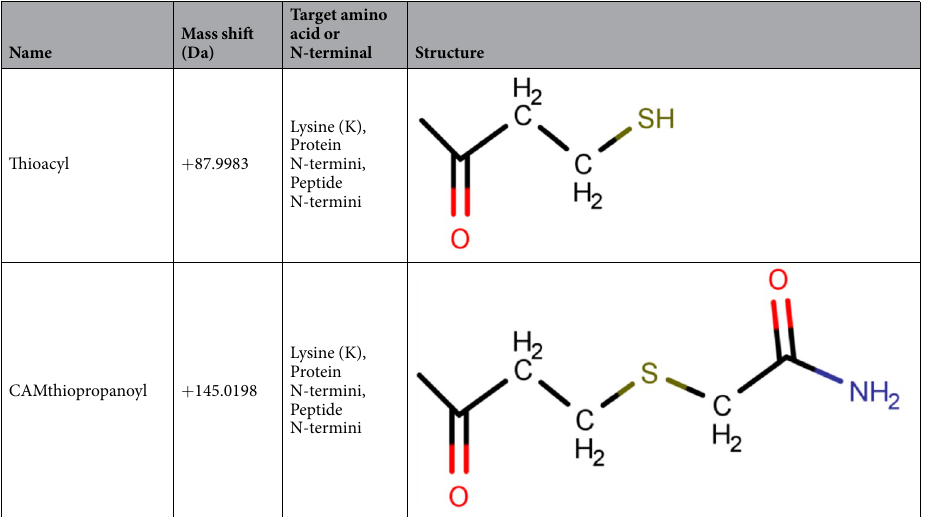
Table 1. Covalent modifications on extracellular primary amino groups.